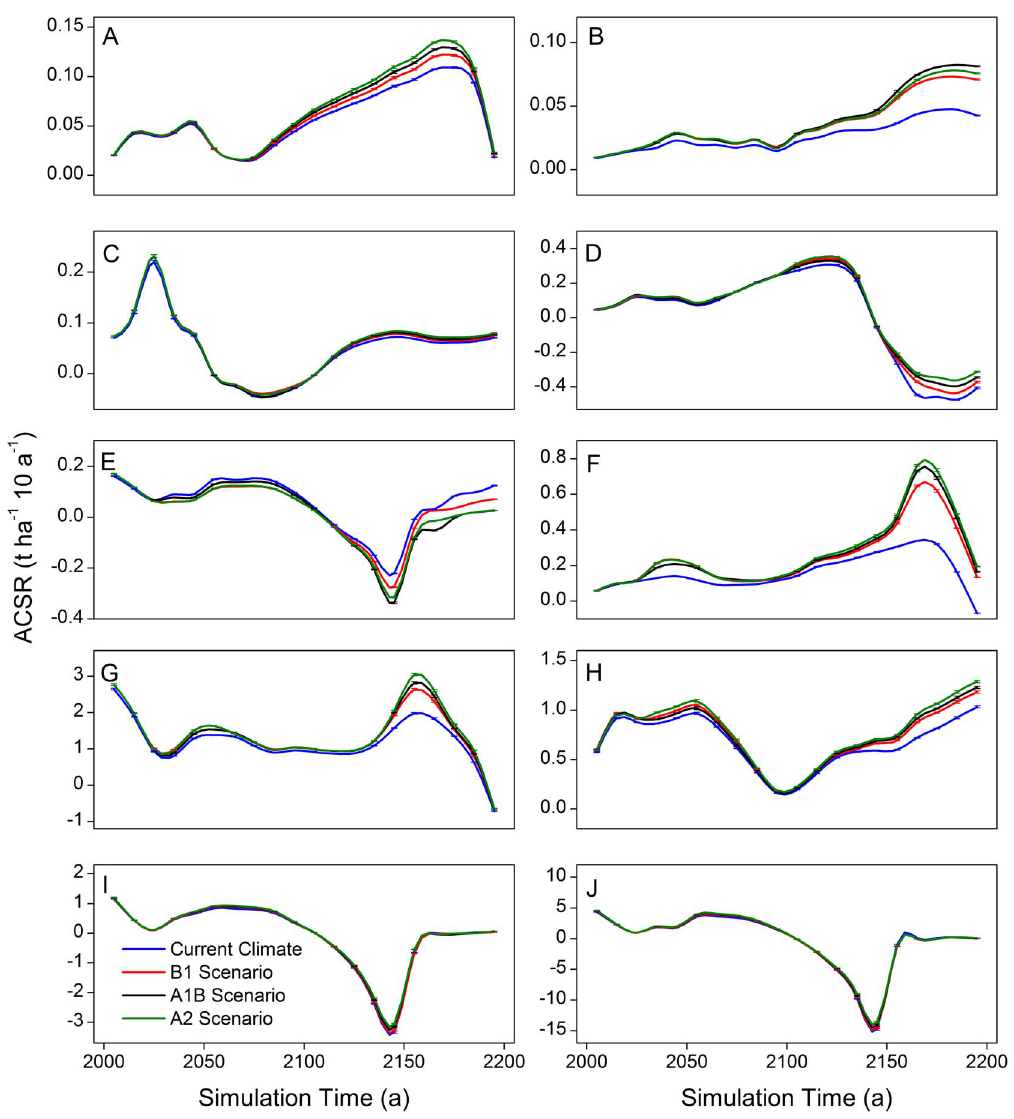
Figure 4. Forest aboveground carbon sequestration rates of ten broad leaved tree species. A: Manchurian ash, B: Amur cork, C: Mongolia oak, D: Mono maple, E: Black birch, F: Black elm, G: Ribbed birch, H: Amur linden, I: Aspen, and J: White birch.